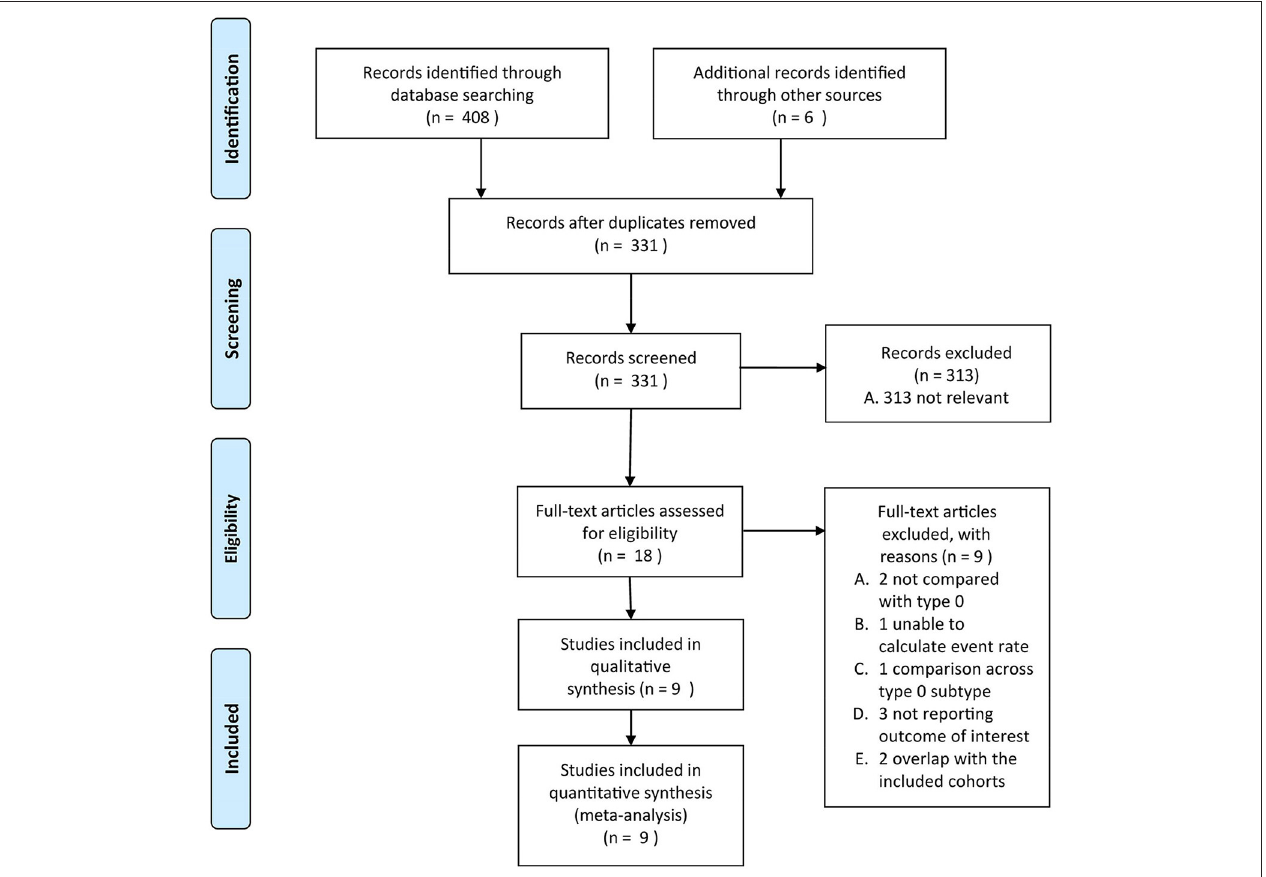
FIGURE 1 | The Preferred Reporting Items for Systematic Reviews and Meta-Analyses (PRISMA) flowchart of the present